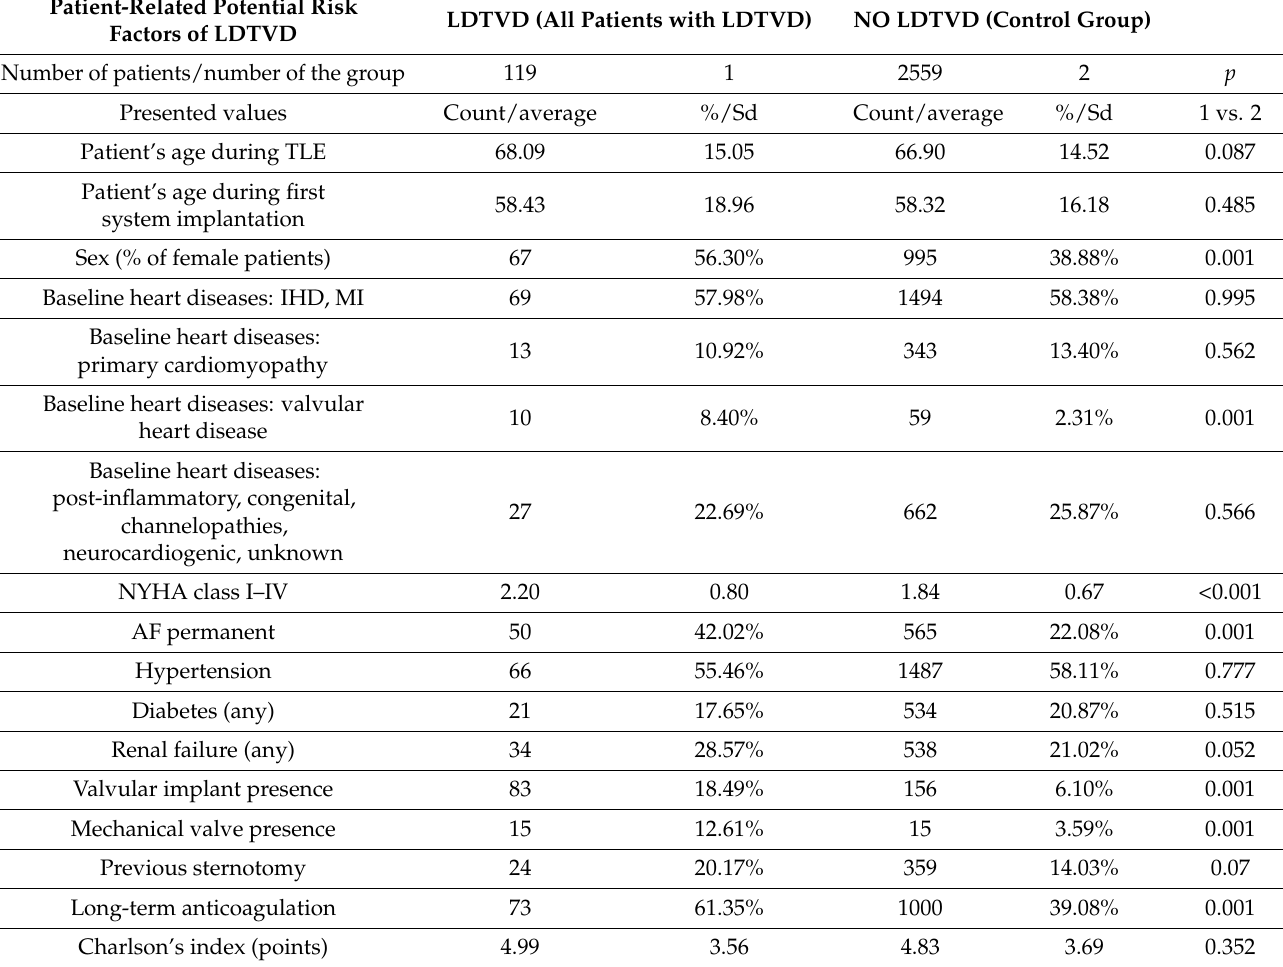
Table 2. Clinical data-classification according to the occurrence of